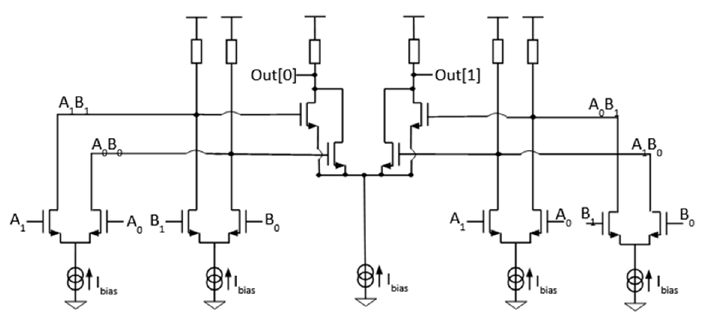
Figure 6. XOR-based fully symmetrical phase detector.